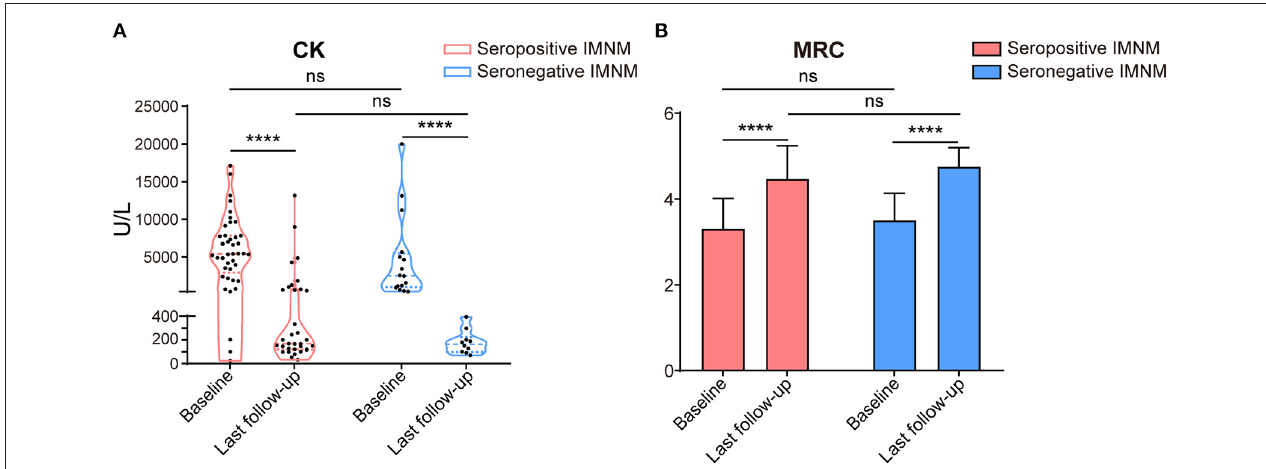
FIGURE 4 | Changes of serum creatine kinase levels and Medical Research Council (MRC) at base and by the last follow-up of patients with seropositive and seronegative immune-mediated necrotizing myopathy (IMNM). (A) A violin plot with median and interquartile range of serum creatine kinase (CK) levels of the seropositive and seronegative patients at baseline and last follow-up (for seropositive IMNM group: baseline n = 41, last follow-up n = 33; for seronegative IMNM group: baseline n = 16, last interview n = 10). **** p < 0.0001; ns, no significance. (B) A histogram with median and standard deviation of MRC grade of the patients with seropositive IMNM and seronegative IMNM (for seropositive IMNM group: baseline n = 43, last follow-up n = 41; for seronegative IMNM group: baseline n = 16, last interview n = 10). **** p < 0.0001; ns, no significance.